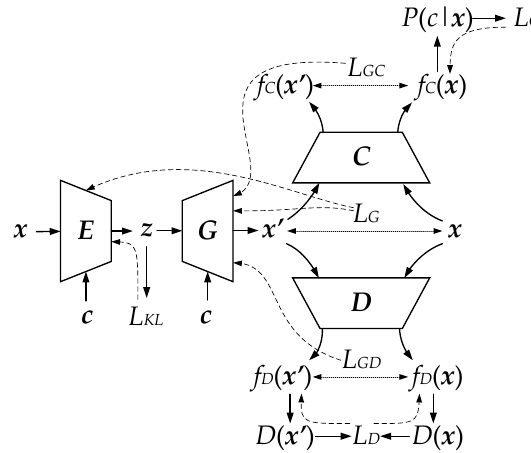
Figure 2. Framework of the proposed CVG-MFICNN diagnosis method.